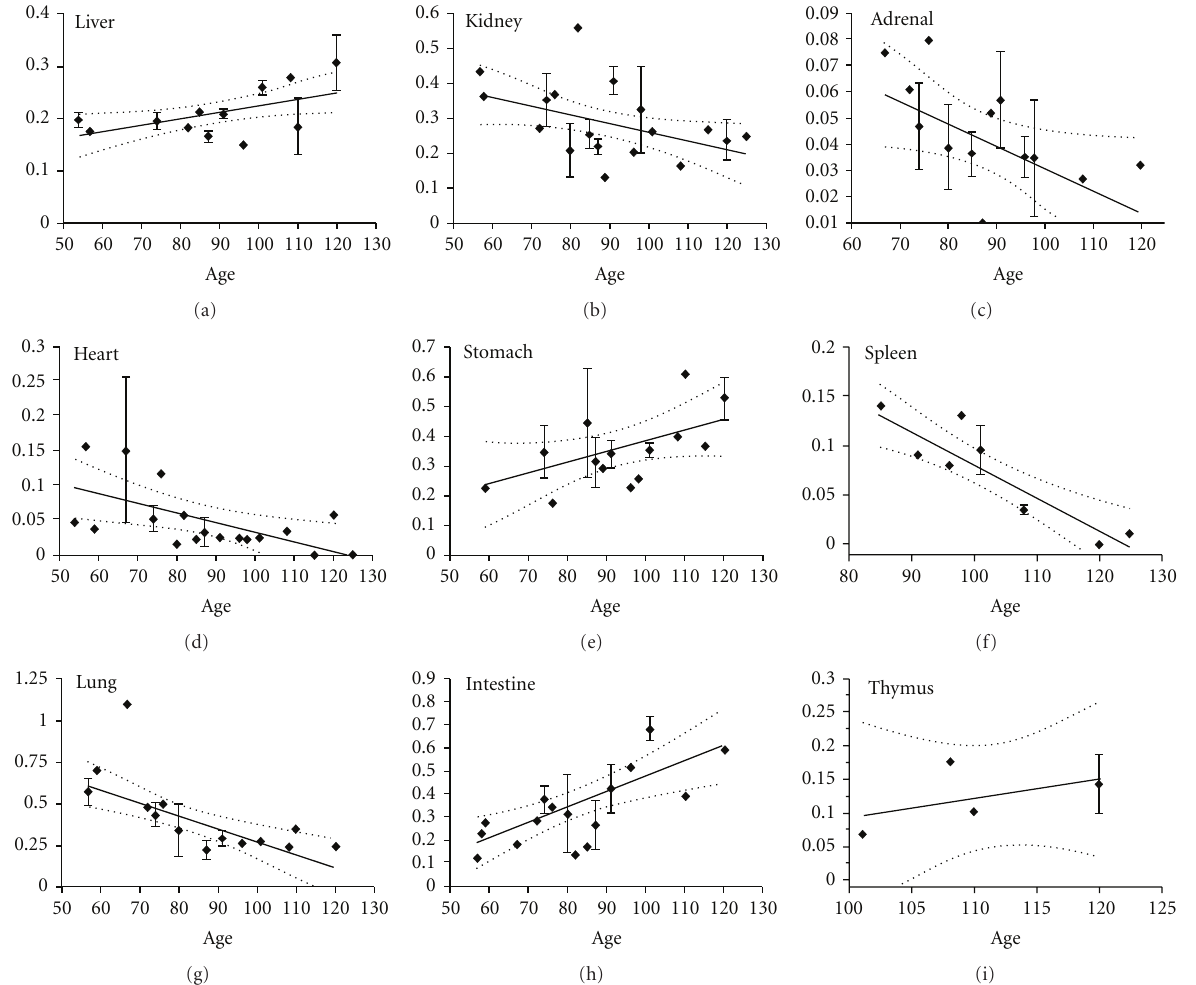
Figure 2: PPAR γ protein expression is shown across the fetal age range for each tissue. Western blot density normalized to glyceraldehyde- 3-phophate dehydrogenase (GAPDH). If only one sample was available for a particular age, then an error term could not be calculated and no SEM bar is shown. Regression analysis evaluated change with age. Dashed lines are the 95% confidence